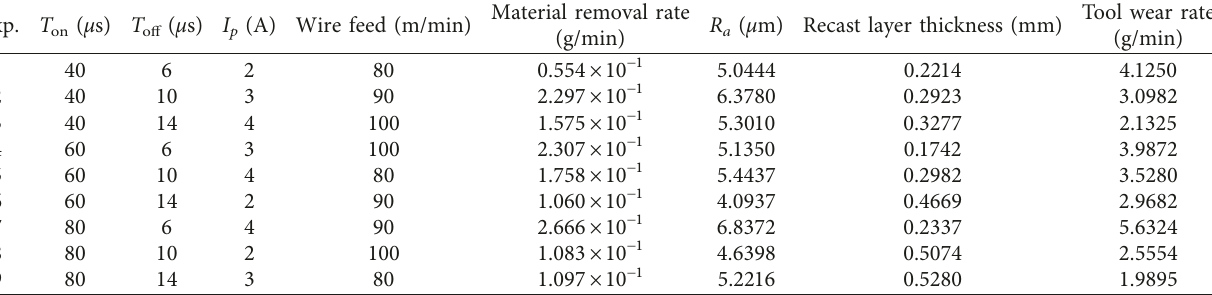
Table 3: Design of experiments using brass wire as a tool.